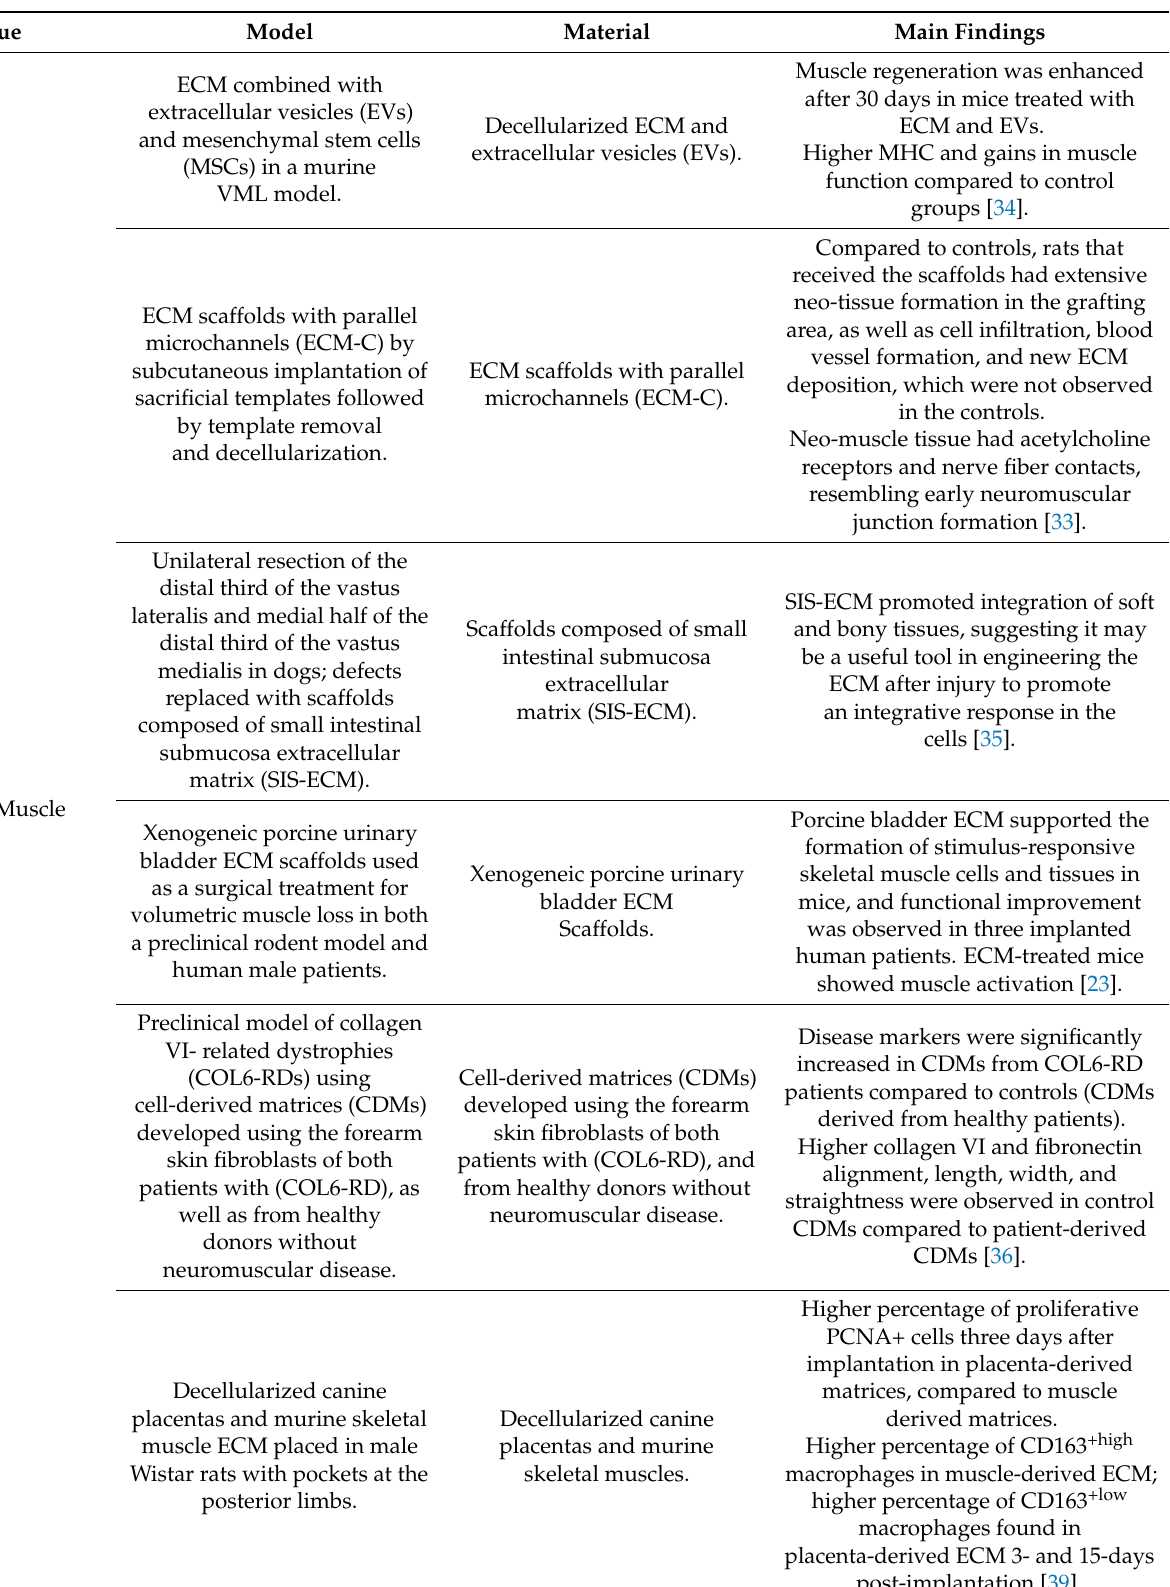
Table 1. Recent and noteworthy studies focused on cell–ECM–material interactions in skeletal